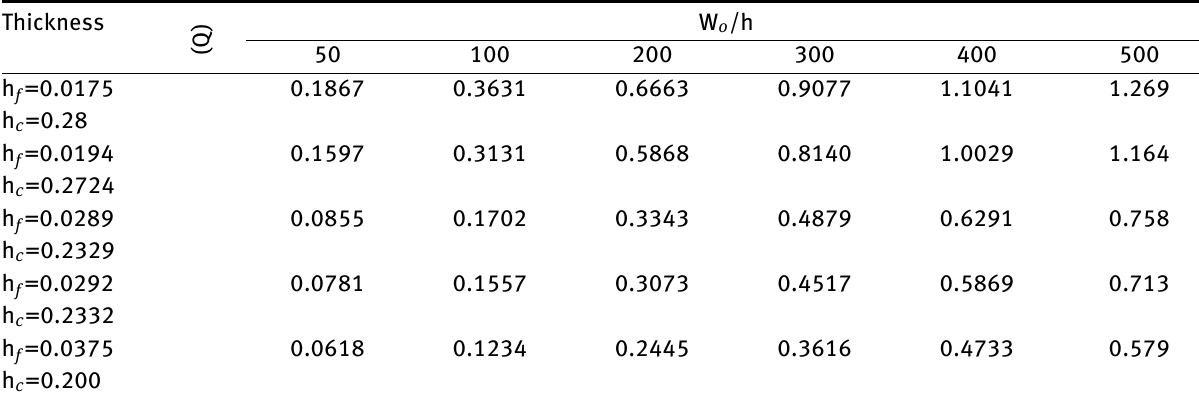
Table 2: Effect of core and sheet thickness variation on transverse central deflection of SWCNTRC sandwich beam